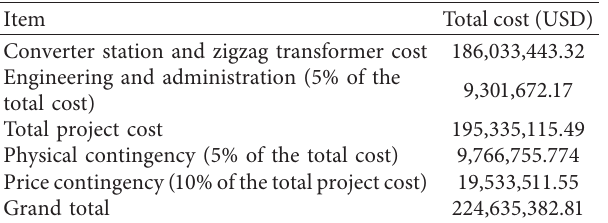
Table 5: Simultaneous AC-DC transmission system